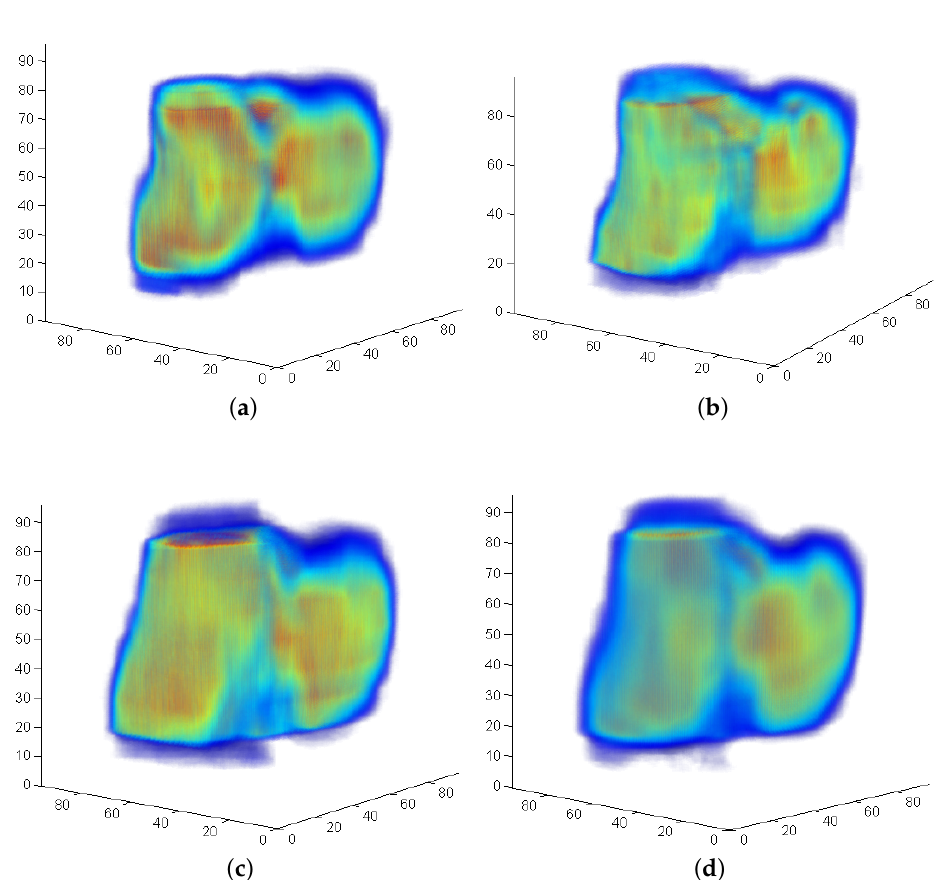
Figure 6. Example bone B1. Each average bone is generated by a Low Frequency adaptation of Fourier-Mellin-SOFT (LF-FMS) registration of the complete scan sequence of the hand movement. The figures show that small details are clearly recognizable. ( a ) B1—person 1 average bone from all available positions. ( b ) B1—person 2 average bone from all available positions. ( c ) B1—person 3 average bone from all available positions. ( d ) B1—average bone from all test